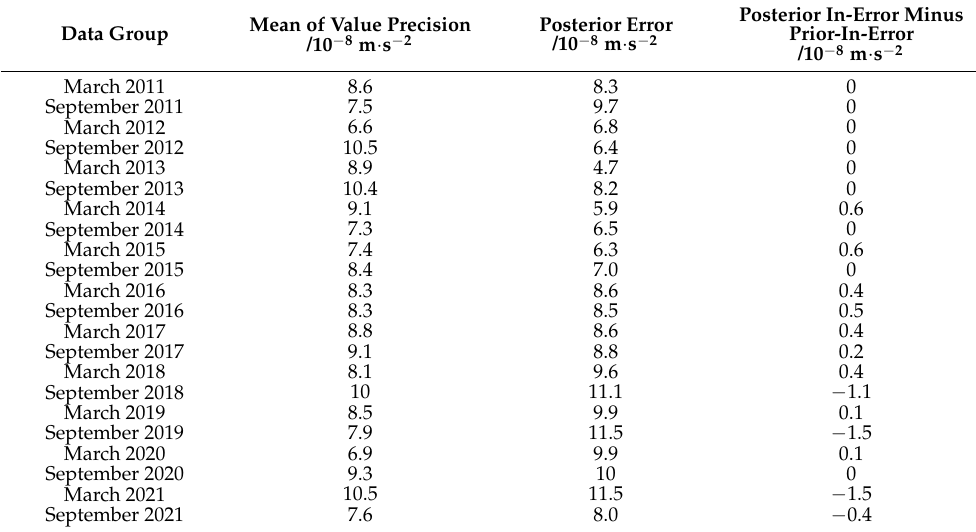
Table 1. Accuracy of gravity data processing results from March 2011 to September